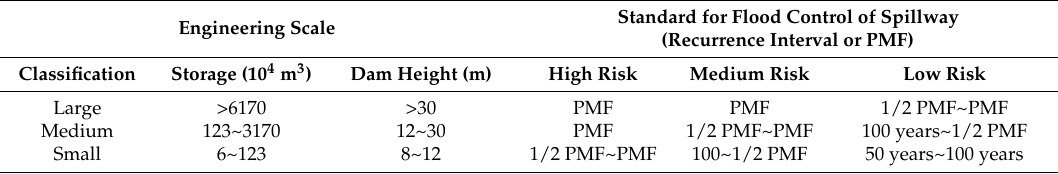
Table 5. Flood control standard for spillway by The Army Corps of Engineers (USACE).